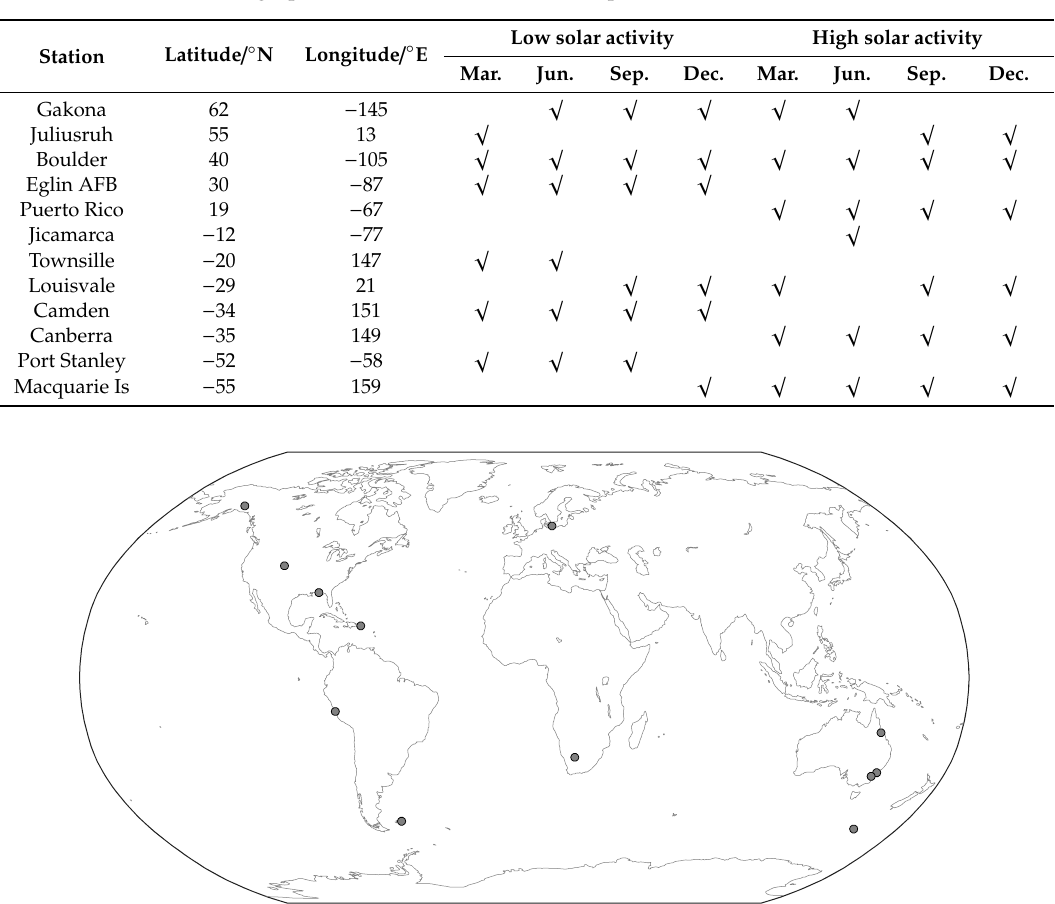
Table 2. Geographic coordinates and validation periods of the selected stations.